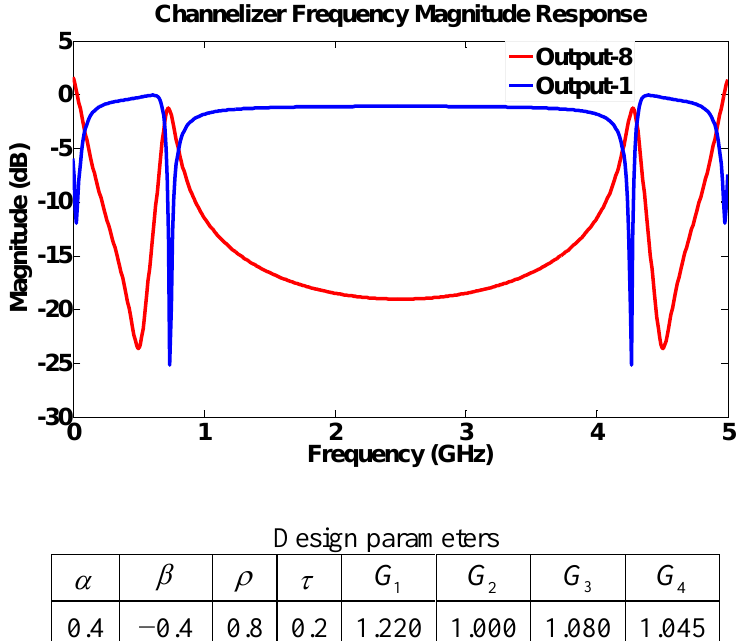
Figure 11. Frequency response for structure III using high reflection parameters.